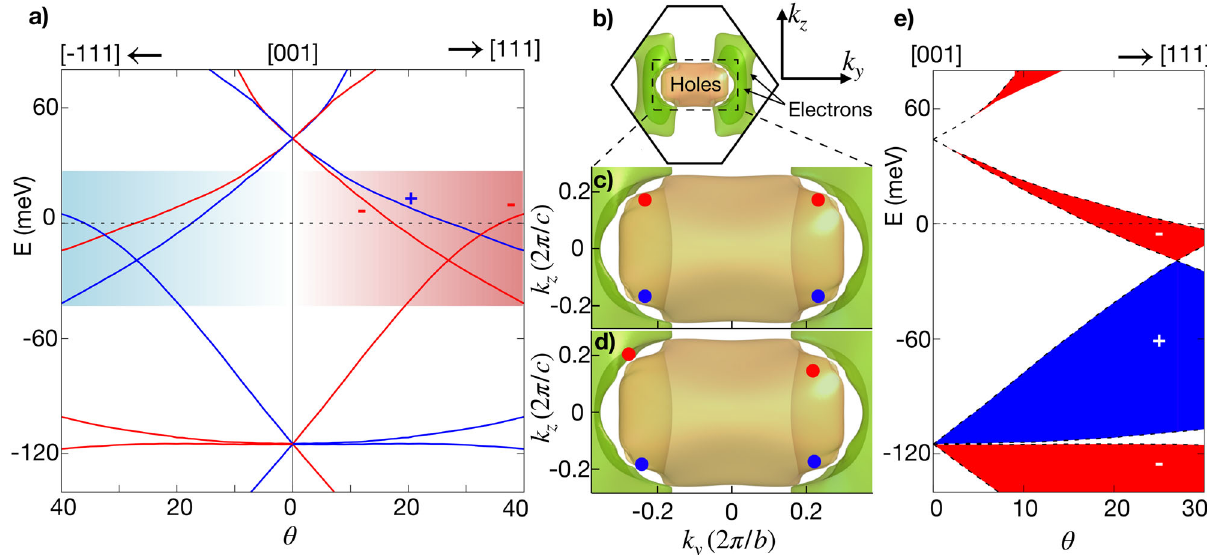
Fig. 3 Pumping chirality to and through the Fermi surface. a Energy of Weyl nodes in NdRhC 2 as a function of the canting angle θ . Starting from the magnetization along the direction [001], on the left the canting is toward [ − 111], while on the right is toward [111]. Blue and red correspond to Weyl nodes of positive and negative chirality, respectively. The colored region highlights a wide angle range in which near the Fermi surface Weyl fermions of one chirality are majority. b Bulk Fermi surface for θ = 0. c Zoom into the Fermi surface showing the Weyl nodes closest to it for θ = 0. A Weyl node quartet places inside a hole pocket. d Same for θ ~ 20, where now a single Weyl node has moved into an electron Fermi surface, leaving a net chirality in the hole pocket. e Phase diagram in the space of energy and canting angle indicating the regions in which the hole pocket carries a net Chern